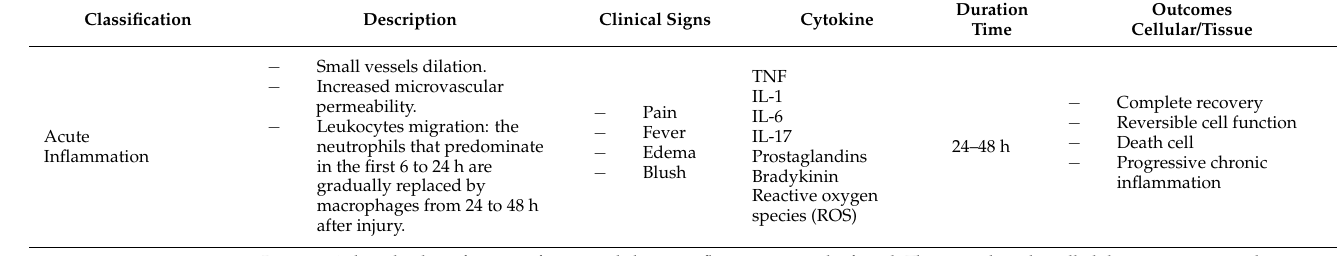
Table 1. Adapted classification criteria based on injury pathophysiology and tissue changes [11–13].